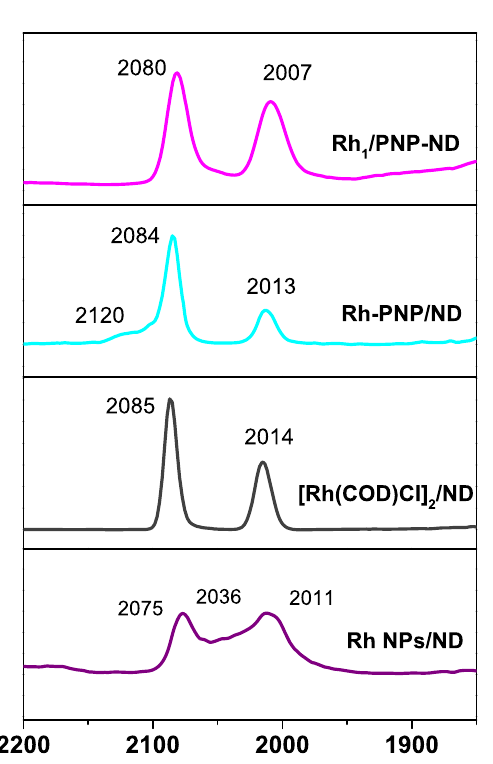
Fig. 5 In situ CO-DRIFTs spectra of Rh catalysts. Prior to characterization, all the samples were pretreated under helium at 200 °C for 1 h, and then further treated in 1% CO/He for 1 h. A series of infrared spectra curves for Rh 1 /PNP-ND, Rh-PNP/ND, [Rh(COD)Cl] 2 /ND, and Rh NPs/ND were measured over time (see Supplementary Information for